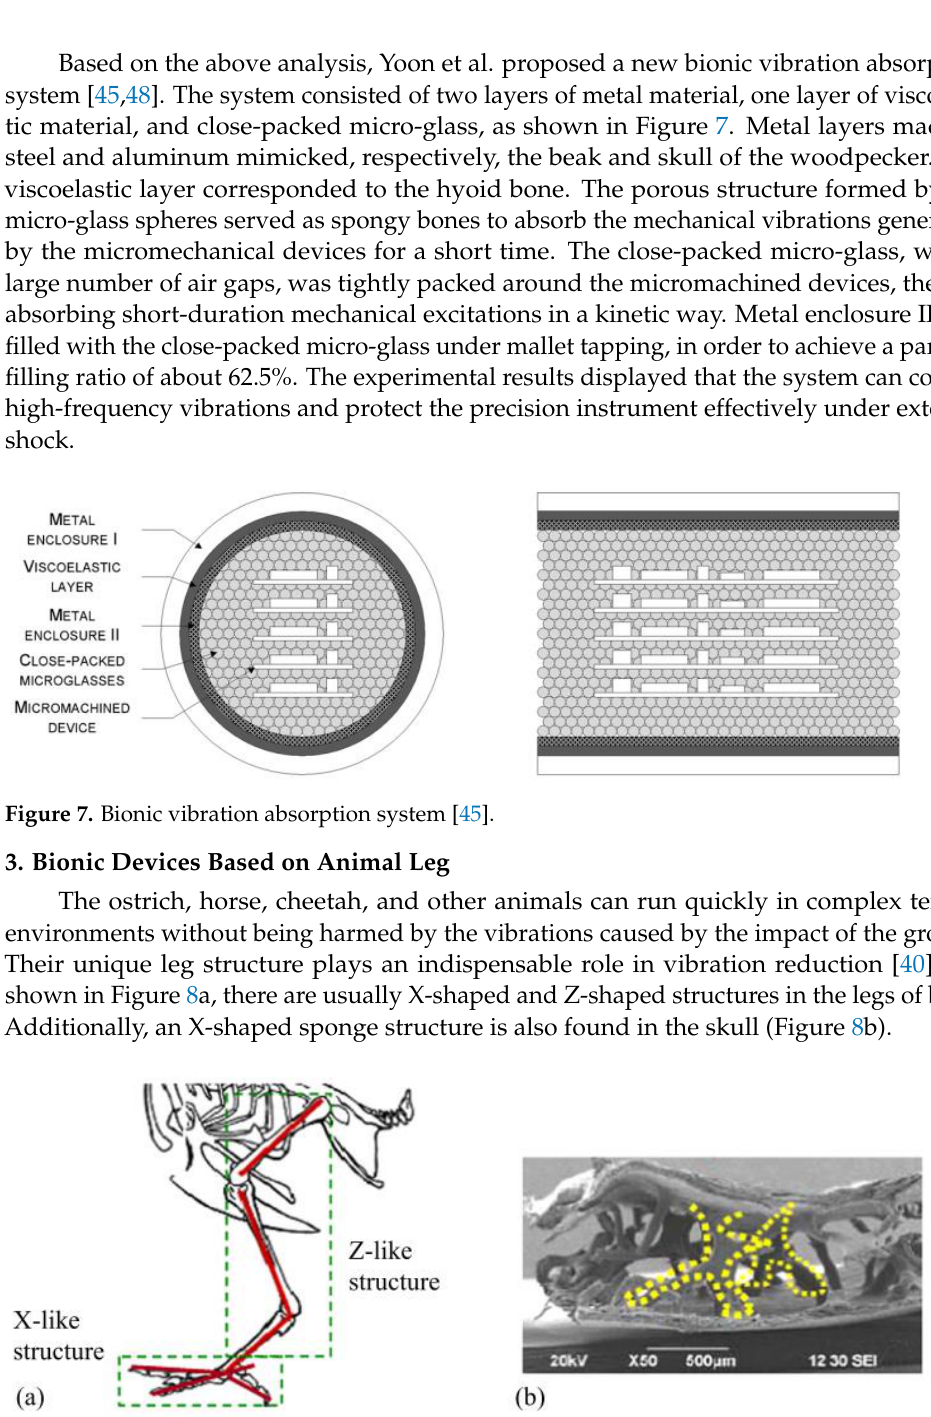
Figure 6. Simplified vibration reduction model of woodpeckers ’ brains as they hit tree trunks [45].